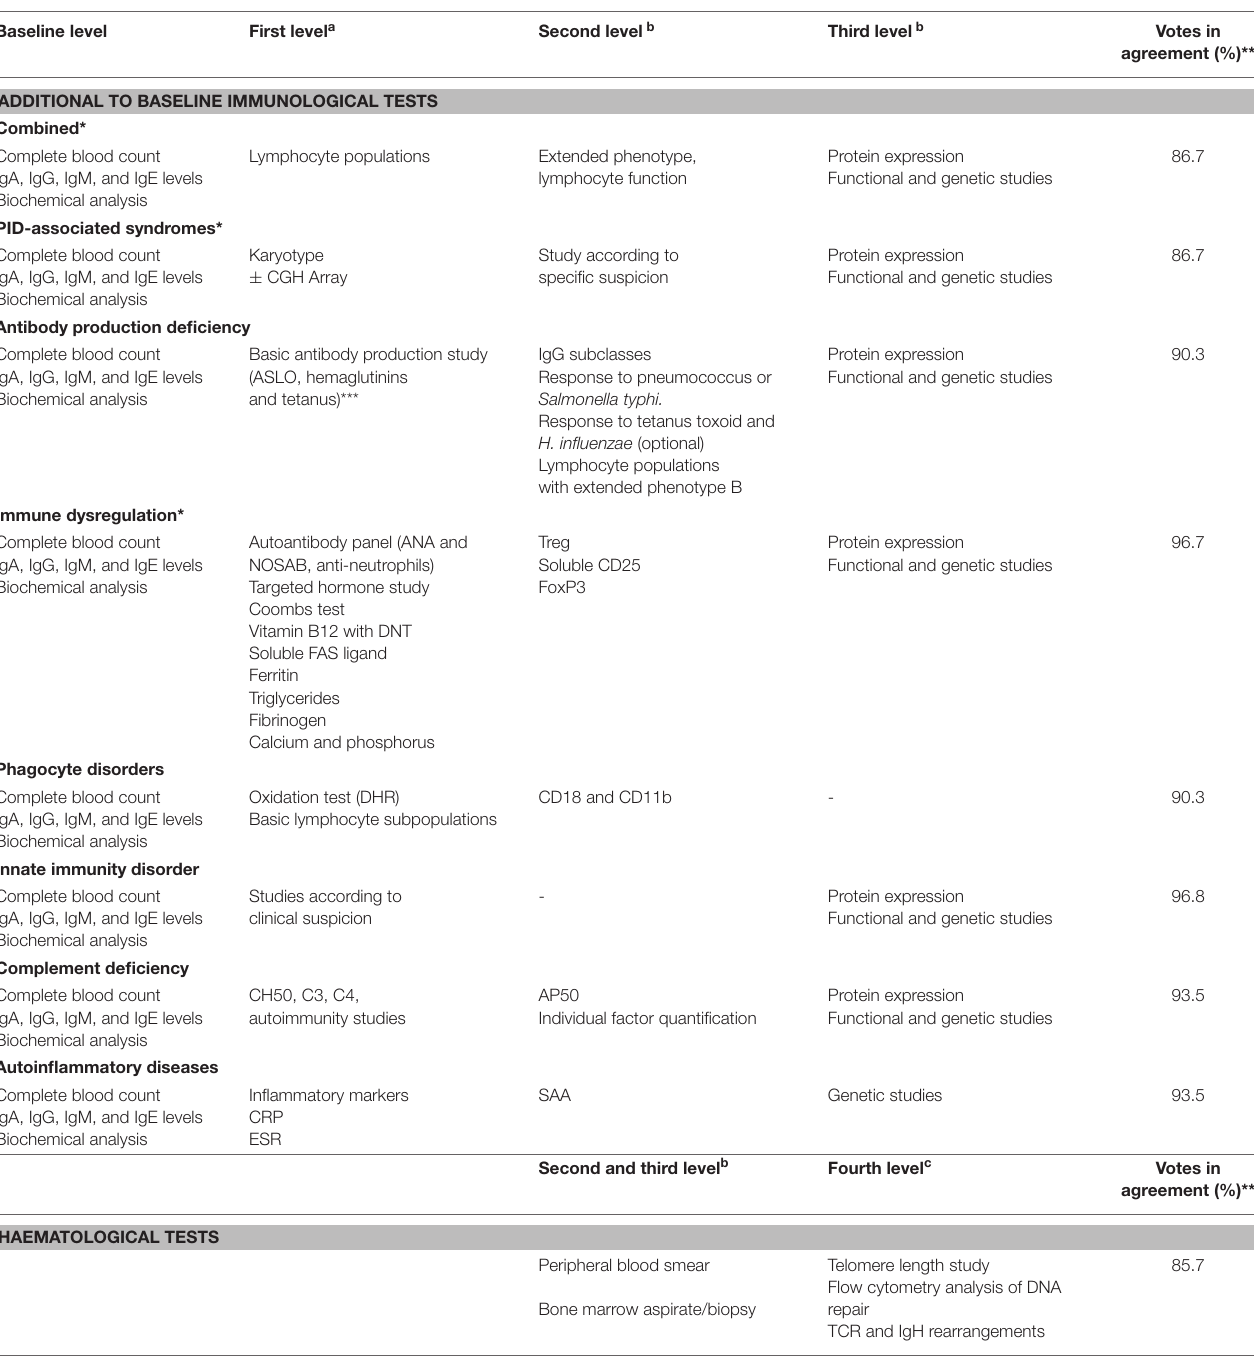
TABLE 3 | Additional to baseline immunological and haematological tests in patients with suspected PID. Baseline